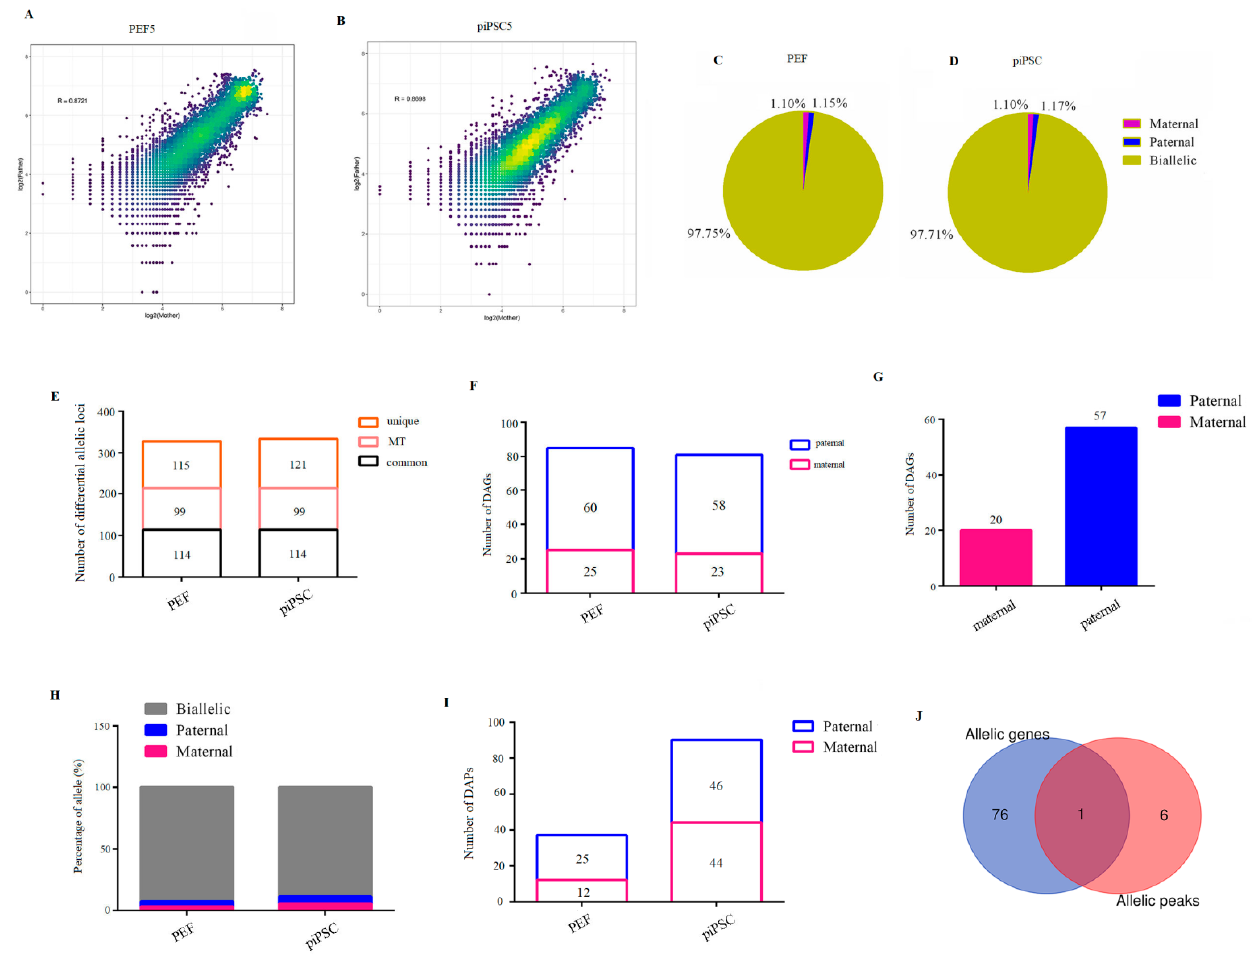
Figure 5. Identification of parent ‐ of ‐ origin ‐ dependent genes and parent ‐ of ‐ origin ‐ dependent ac ‐ cessible chromatin. ( A , B ) Scatter plots show comparable transcription activities between two pa ‐ rental genomes in PEF5 ( A ) and piPSC5 ( B ). ( C , D ) Percentage of maternal ‐ expression and pater ‐ nal ‐ expression loci in three PEF cell lines ( C ) and three piPSCs ( D ) for RNA ‐ seq data. ( E ) Numbers of differential allelic loci in PEFs and piPSCs for RNA ‐ seq data. ( F ) Numbers of paternal differential allelic genes in PEF ‐ unique loci and piPSC ‐ unique loci, respectively. ( G ) Numbers of differential allelic genes in PEF ‐ and piPSC ‐ common loci. ( H ) Percentage of maternal ‐ and paternal ‐ allele open loci in three PEF cell lines and three piPSCs for ATAC ‐ seq data. ( I ) Number of differential allelic peaks in PEFs and piPSCs, respectively. ( J ) Overlap of parent ‐ of ‐ origin ‐ dependent genes and par ‐ ent ‐ of origin ‐ dependent peak ‐ related genes. To understand whether the allelic imbalance of allele ‐ biased expressed genes is regulated by allele ‐ biased open chromatin, we researched parent ‐ of ‐ origin ‐ dependent accessible chromatin after blasting parental discrepant SNP loci into ATAC ‐ seq data. We acquired 3223 SNP loci in ATAC ‐ seq data whose parental chromatin loci could be totally separated in ATAC ‐ seq data (Table S15). We found 3.29% maternal allele ‐ biased open loci and 4.22% paternal allele ‐ biased open loci in PEFs, accounting for 12 maternally open peaks and 25 paternally open peaks in PEFs (Figure 5H,I and Table S16). A total of 5.24% maternal allele ‐ biased open loci and 5.71% paternal allele ‐ biased open loci were found in piPSCs, accounting for 44 maternally open peaks and 46 paternally open peaks in piPSCs (Figure 5H,I and Table S17). After co ‐ analysis of differential allelic genes and differential allelic peaks, we found only one gene was overlapped between allele ‐ specific ATAC ‐ seq